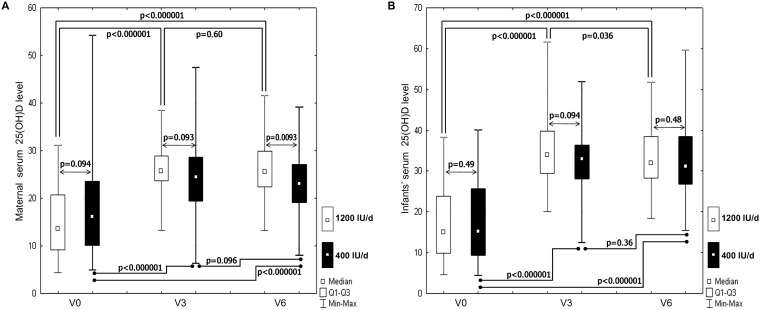
Maternal (A) and infants’ (B) serum 25(OH)D concentrations at baseline and during vitamin D supplementation in the study groups (maternal vitamin D dose: 400 IU/d vs. 1200 IU/d).The effects of group (maternal vitamin D dose) × time interaction, group (maternal vitamin D dose) and time on maternal and infants’ serum 25(OH)D levels were obtained from a two-factor repeated-measures ANOVA. P-values for these effects among mothers are 0.00042, <0.000001, 0.25, and among infants 0.12, <0.000001, 0.45, respectively. P-values presented on the figures (A, B) were obtained from post-test analysis (Fisher’s LSD test) for differences in serum 25(OH) concentrations between the study groups and between the study visits. P-values<0.05 are significant. The study visits: V0- the baseline visit, V3, V6 – the visits after 3 and 6 months of vitamin D supplementation.